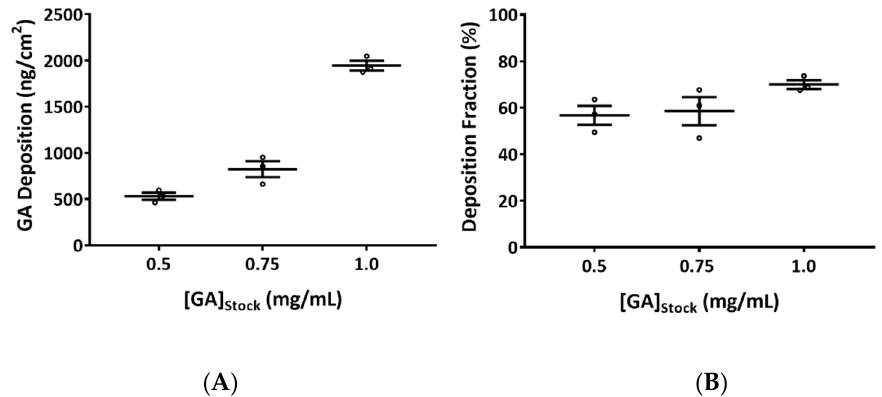
Figure 1. Quantification of glutaraldehyde (GA) aerosol deposition in the Cloud System. ( A ) Deposition of GA from 0.5, 0.75, and 1.0 mg/mL of the stock solutions was quantified using a UPLC method. Three independent nebulizations, each consisting of three representative positions, were conducted. Average deposition was calculated and presented. ( B ) Deposition fraction for each stock solution was graphed. Data ( n = 3) are expressed as means ± standard error of the mean (SEM).